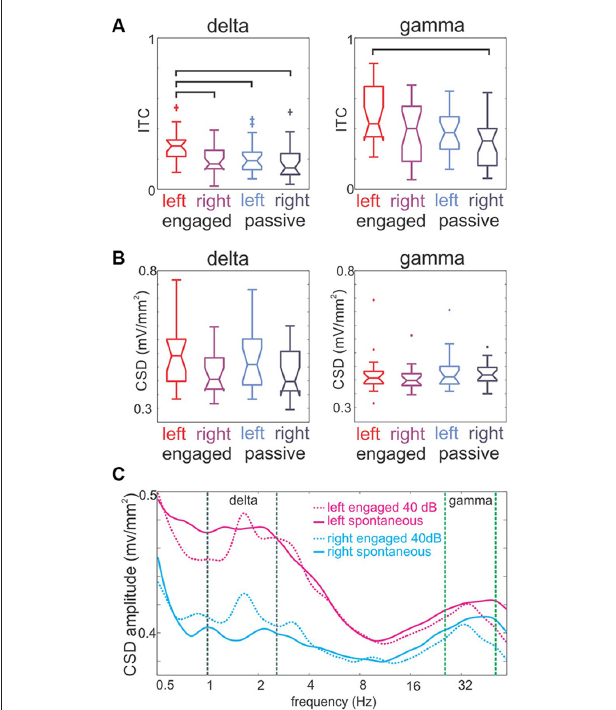
FIGURE 7 | Hemispheric lateralization of intertrial phase coherence and the amplitude of delta and gamma oscillations. (A) Pooled delta and gamma (1.6 and 33 Hz) Inter-trial coherence (ITC) values in left and right A1 sites in engaged and passive conditions. Generally, engagement results in a significant ITC increase (see “Results” Section), and both delta and gamma ITC is higher in left hemisphere sites. Brackets mark significant differences (Tukey’s test, p < 0.01). (B) Pooled delta and gamma oscillatory amplitudes in left and right hemisphere A1 recordings in engaged and passive conditions. Both delta and gamma amplitude values follow the same trend as ITC, but none of the effects are significant. (C) Spectra of ongoing and 40 dB click-train stream related activity in the engaged